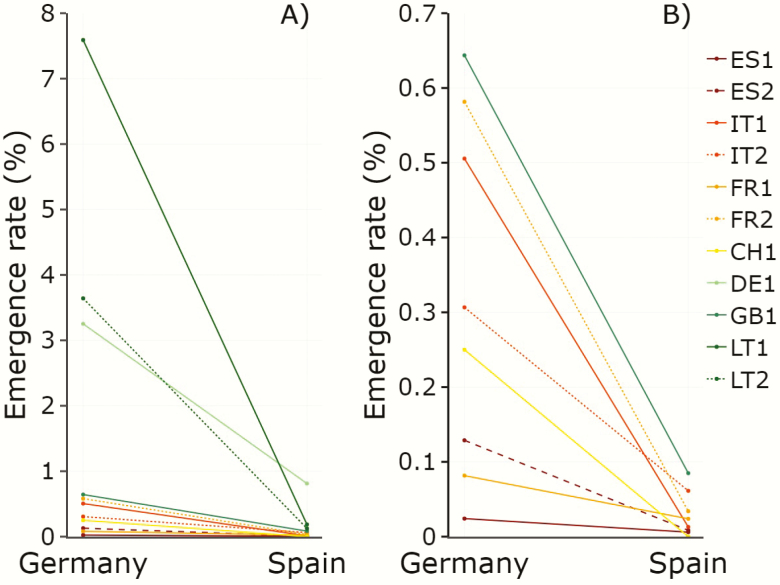
Population means (dots) and reaction norms (lines) for seedling emergence rates of the studied populations of Betula pendula in two common gardens in Germany and Spain. Panel (A) shows all studied populations in both common gardens. Panel (B) displays the zoom-in of populations with emergence rates below 1 %. Population codes as in Table 1. Standard errors are not shown for clarity.